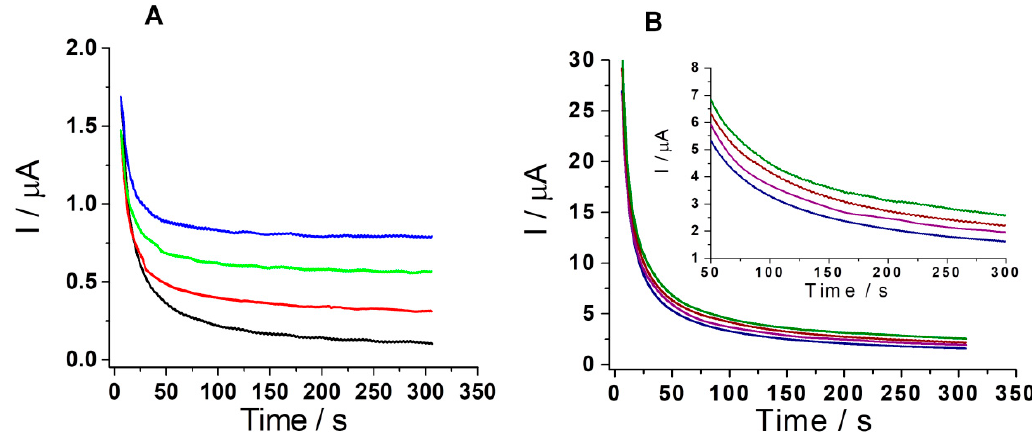
Figure 11. CAs for DOX ( A ) and SMV ( B ) quantification in solutions obtained from pharmaceutical forms (PB pH 5 + 25% EtOH, in CA at 0.5 V for DOX (blank test: black; 10 µ g/mL—red; 25 µ g/mL—green; 50 µ g/mL—blue) and 0.95 V for SMV (blank test: royal blue; 10 µ g/mL—purple; 25 µ g/mL—wine; 50 µ g/mL—olive); under stirring conditions, in the presence of excipients).